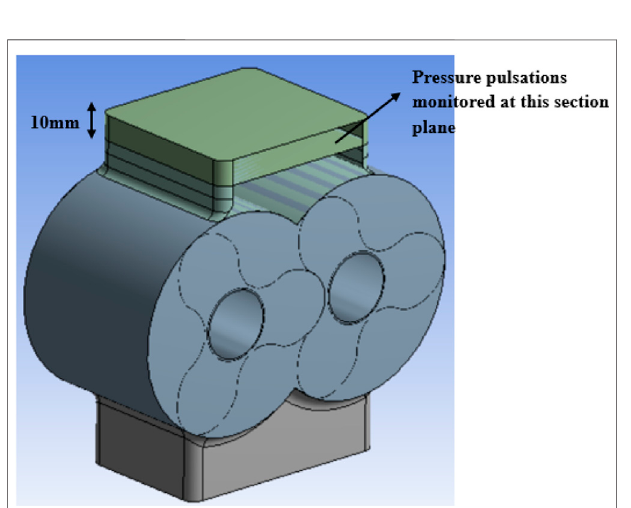
FIGURE 4 | Monitoring pressure pulsations in the outlet port for the EGR pump.